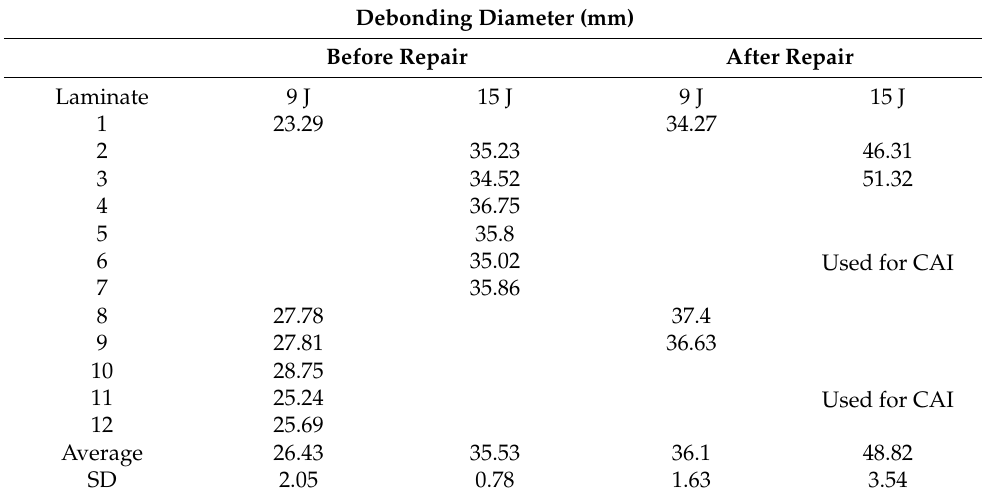
Table 5. Debonding diameters of the impacted 3R laminates.